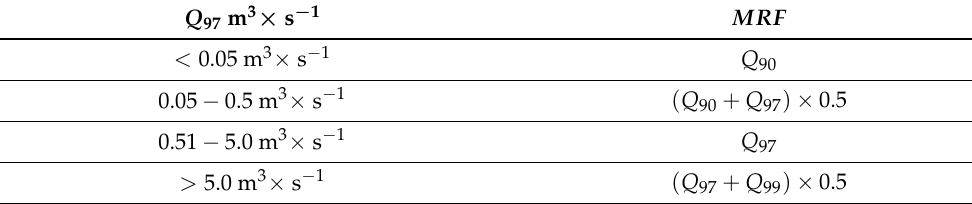
Table 1. Guideline values for the MRF of Q 97